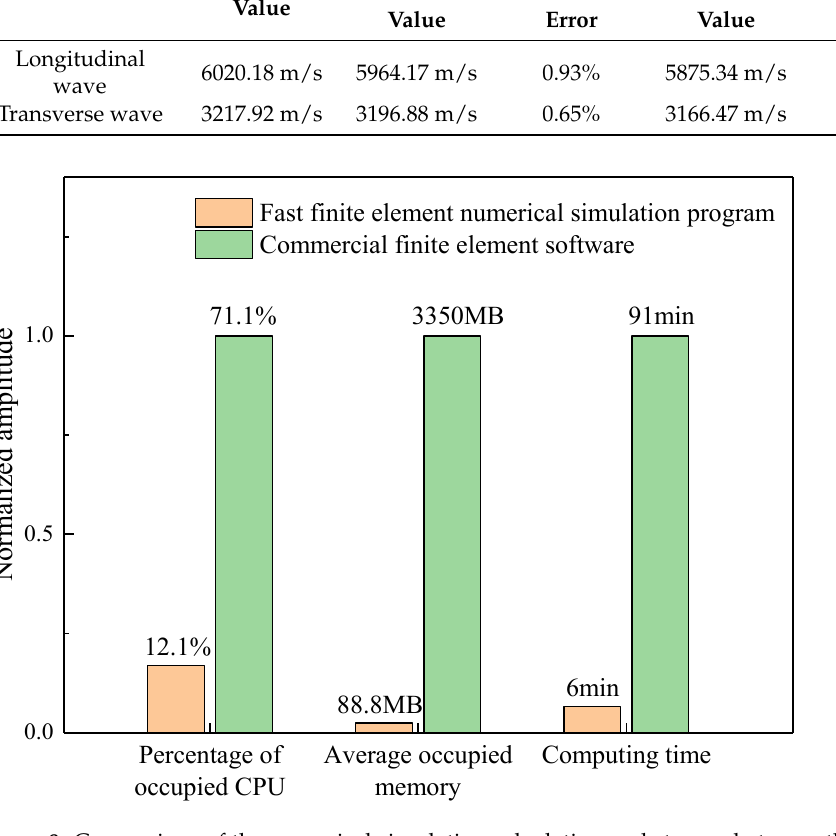
Figure 8. Comparison of the numerical simulation calculation and storage between the fast finite element program and commercial finite element software.